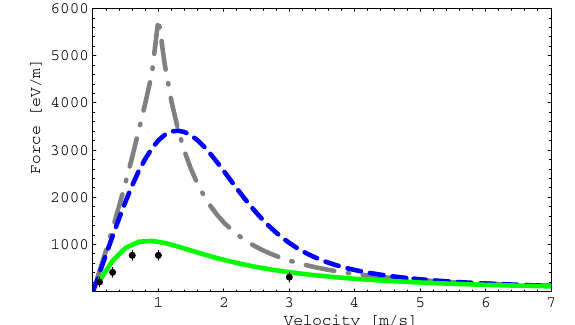
FIG. 2. (Color) Longitudinal component of the force ( eV = m ) vs ion velocity ( (cid:6) 10 5 m = s ). BETACOOL results: solid line (green)—Eq. (9); dot-dashed line (gray)—asymptotics [4]; dashed line (blue)—Eq. (4); VORPAL results: dots with error